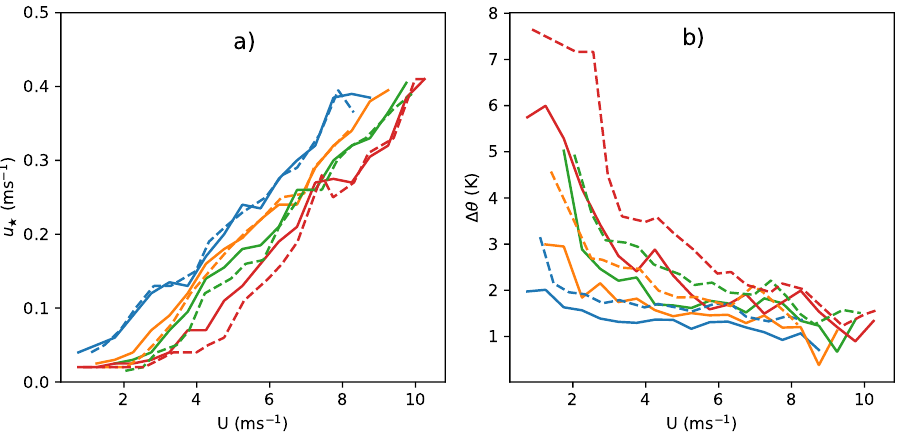
Figure 2. u (cid:63) ( a ) and ∆ θ ( b ) as functions of mean wind speed at several heights. Solid curves represent the median values for regularly spaced bins of U , and dashed curves represent the median values only for the cases when ∆ θ is larger than its median value for each